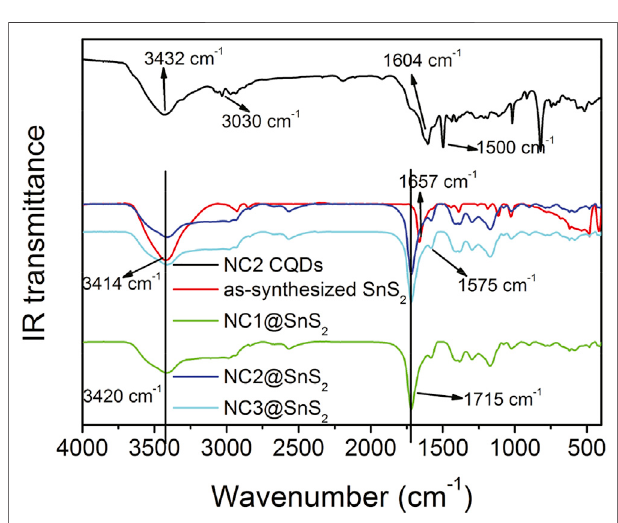
FIGURE 3 | IR spectra of NC2 CQDs, SnS 2 nanoparticles, and NC@ SnS 2